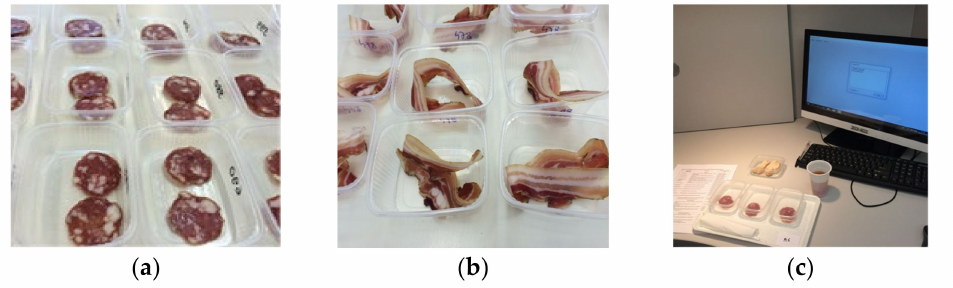
Figure 2. An example of the preparation and presentation of the samples for sensory profiling: ( a ) salami samples, ( b ) pancetta samples, ( c ) preliminary evaluation session with salami (sensory